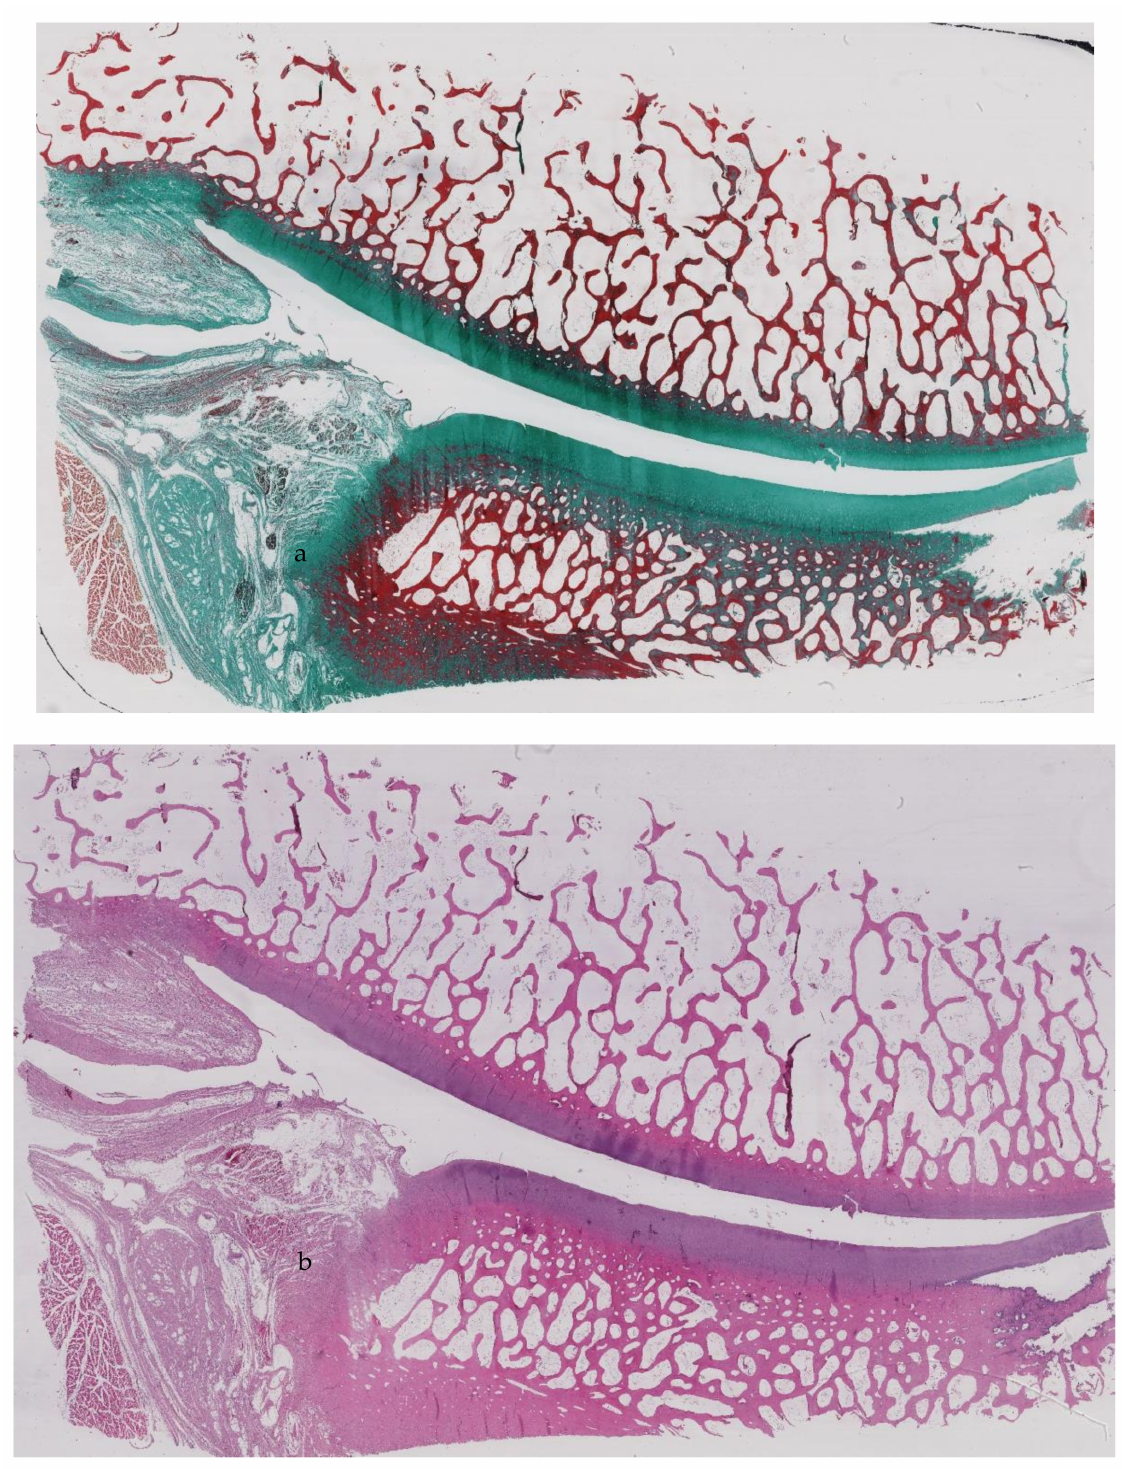
Figure 4. ( a , b ) Histology of the glenohumeral